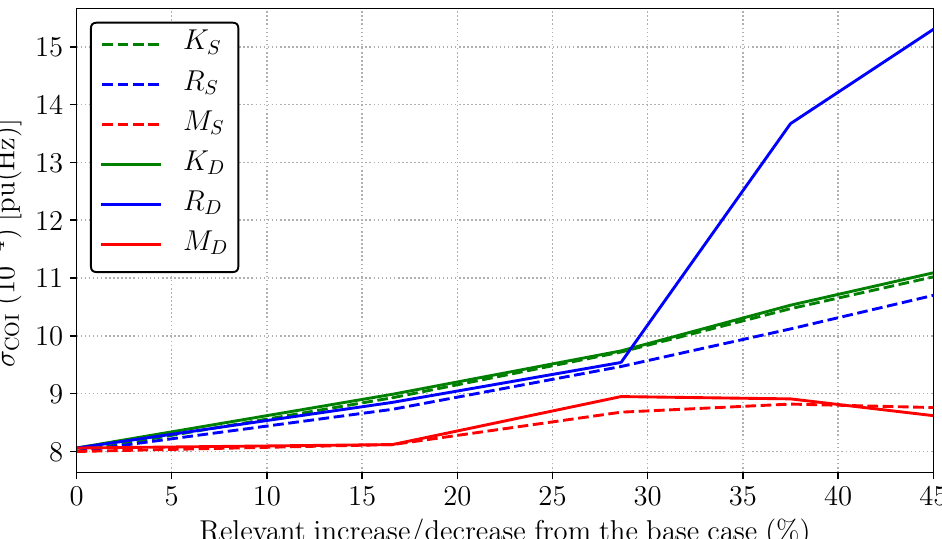
Figure 4. 15-min time period— σ COI as a function of different frequency controllers/machine parameters using the complete SUC and DUC models.